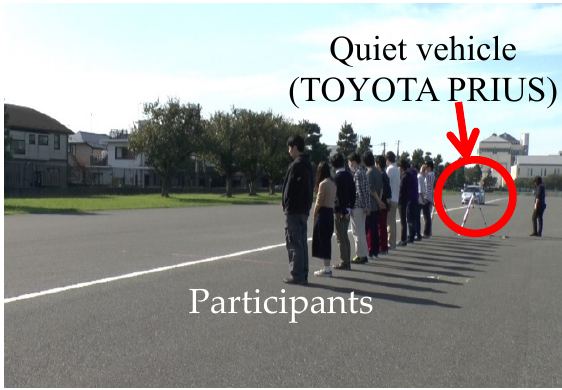
Figure 2. Experimental conditions in Experiment 1.